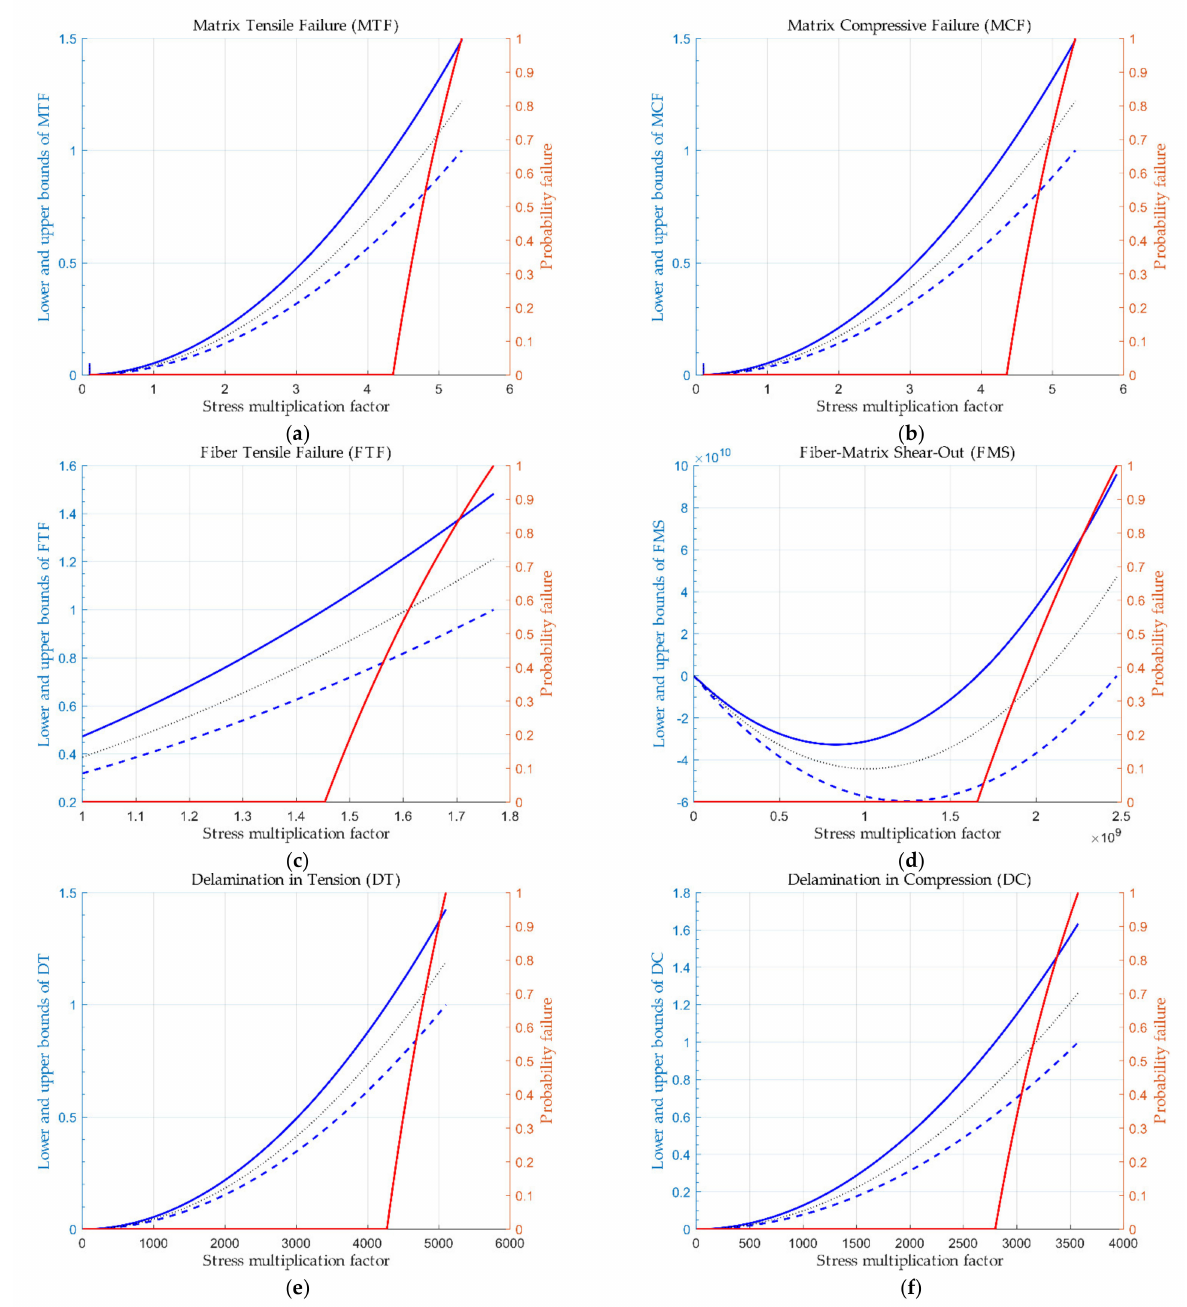
Figure 4. Plots of the upper and lower bounds, the nominal value of failure criteria, and the probability of failure regarding the stress multiplication factor for the AS4-3501/6 UD